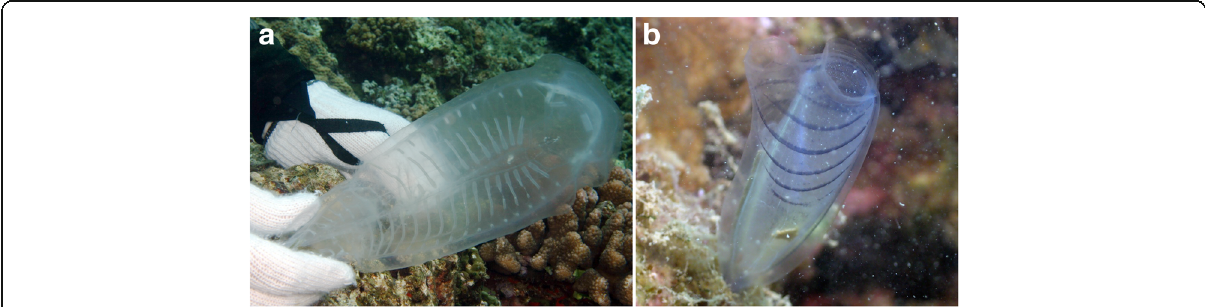
Fig. 1 a Thetys vagina collected near Cape Zanpa (photo: James-Davis Reimer). b Rhopalaea sp. found in Kin Bay (photo: Ryosuke